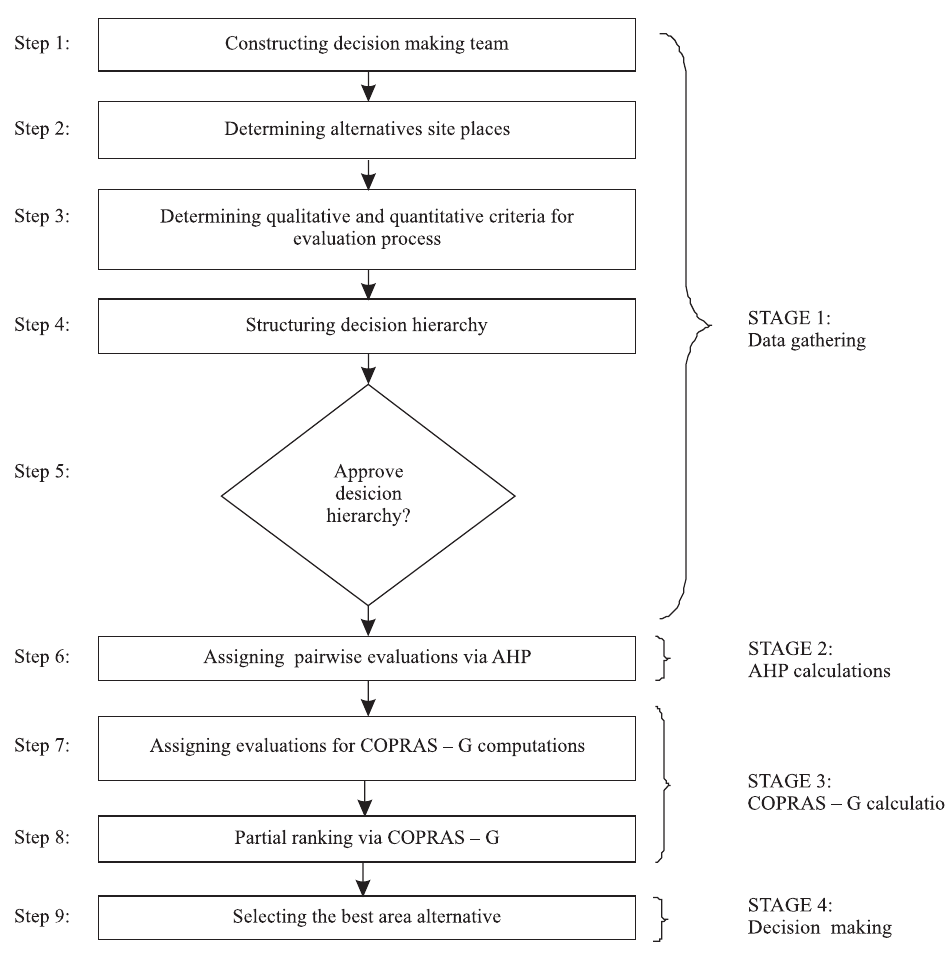
Fig. 1. Schematic representation of the process proposed for area selection process